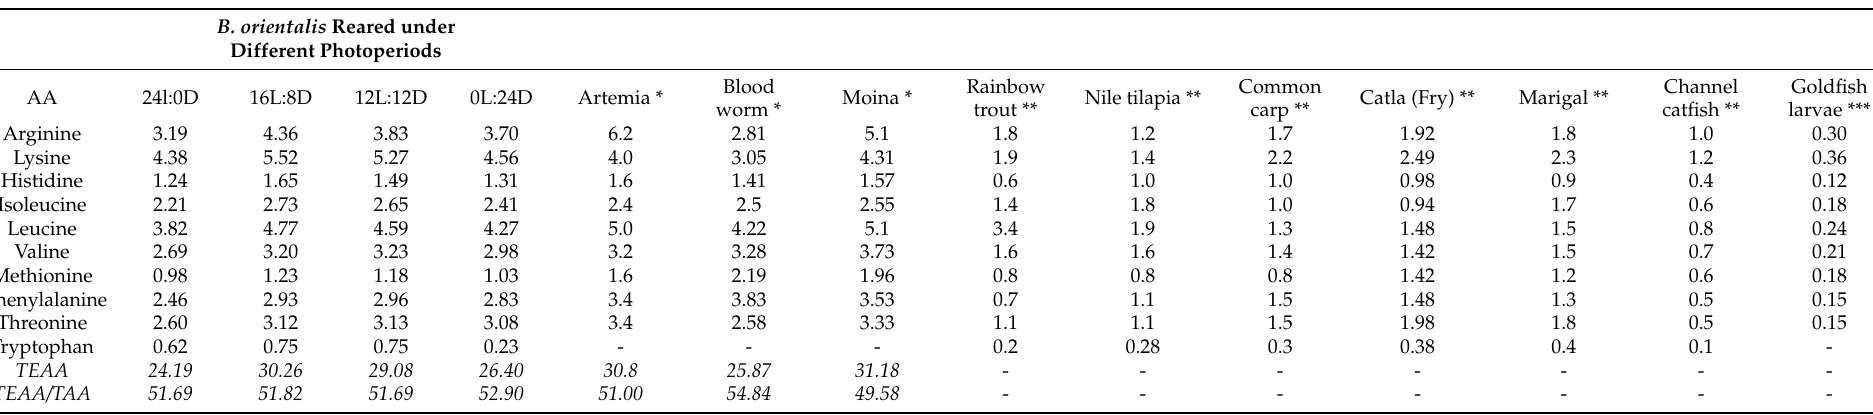
Table 6. Essential amino-acid profile (% dry weight) of B. orientalis , reared under different light/dark cycles, and common live preys used in ornamental freshwater fish nutrition, along with dietary amino-acid requirements of common freshwater finfish. Amino acid (AA), Total amino acid (TAA) and Total essential amino acid (TEAA). B. orientalis Reared under Different